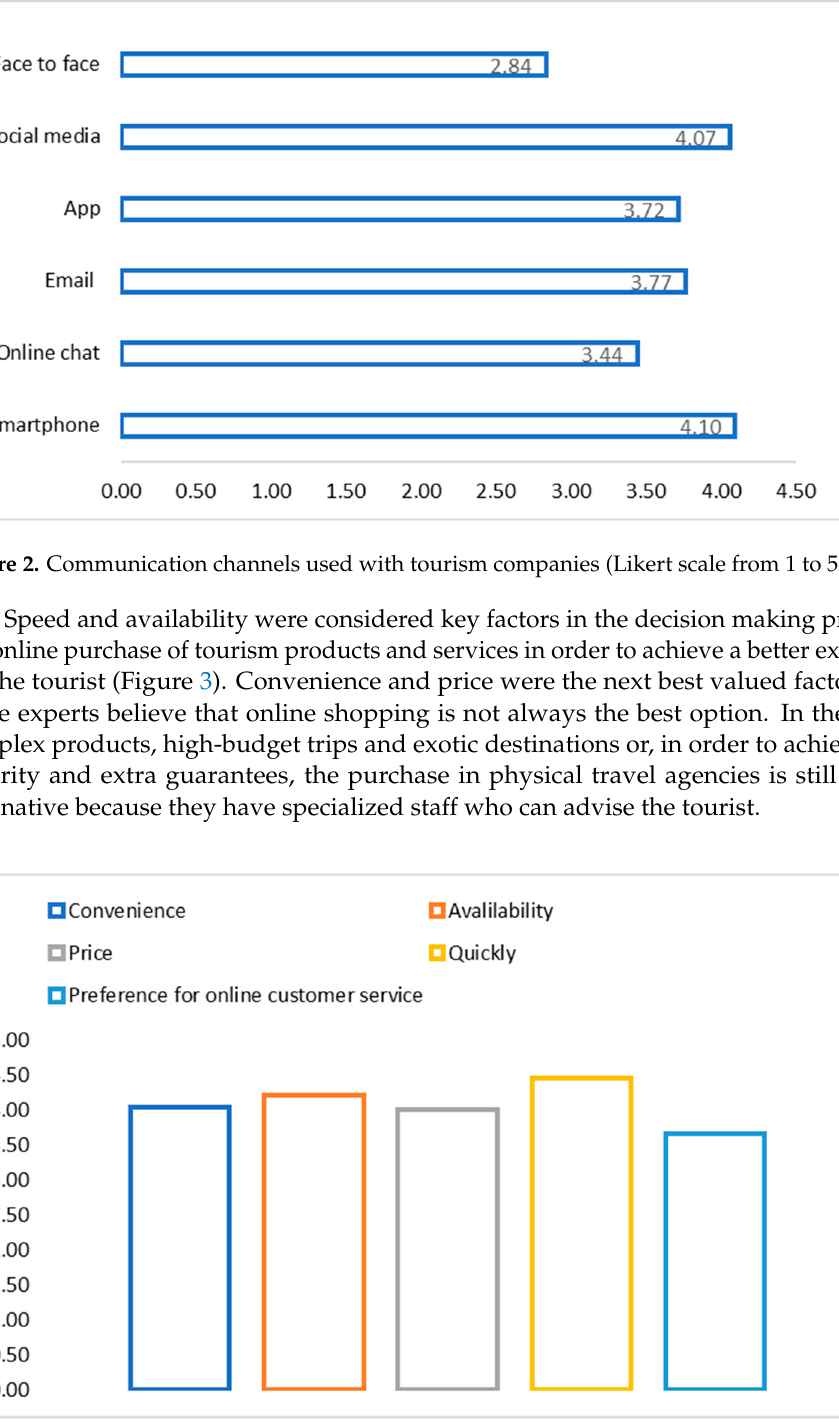
Figure 1. Sources of information for making tourism decisions after the pandemic.